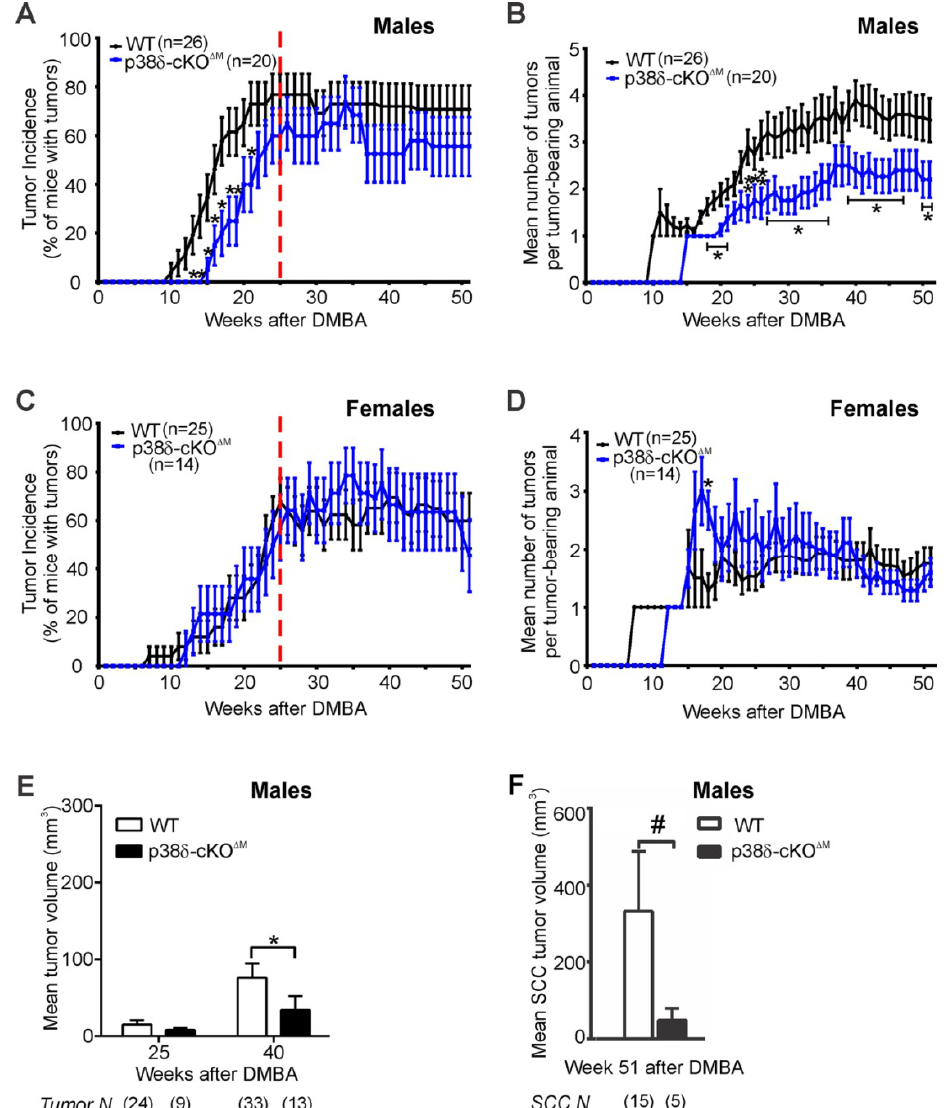
Figure 3. The effects of myeloid cell-specific p38 δ deficiency on skin tumor development. p38 δ -cKO ∆ M male or female mice (LysM-Cre +/ − ; p38 δ flox/flox ) were compared with their WT control counterparts (p38 δ flox/flox and p38 δ flox/+ ) by their responses to the two-stage DMBA/TPA chemical carcinogenesis regimen. ( A , C ) Tumor incidence (mean ± SE). The dashed line marks the week of the last TPA application (Week 25 post-DMBA). * p < 0.05; Fisher’s exact test. ( B , D ) Tumor multiplicity (mean ± SE). * p < 0.05; ** p < 0.01; Fisher’s exact test. ( E , F ) Tumor volume (mean ± SE). Individual tumor volumes were calculated based on the formula: Volume, (mm 3 ) = π × (radius) 2 × height; * p < 0.05; # approaching significance at p = 0.0581; one-sided Mann–Whitney test was used to compare tumor volumes between genotypes at the indicated time points, using the individual tumors as the units of analysis. The numbers of tumors per each group are shown in parenthesis.